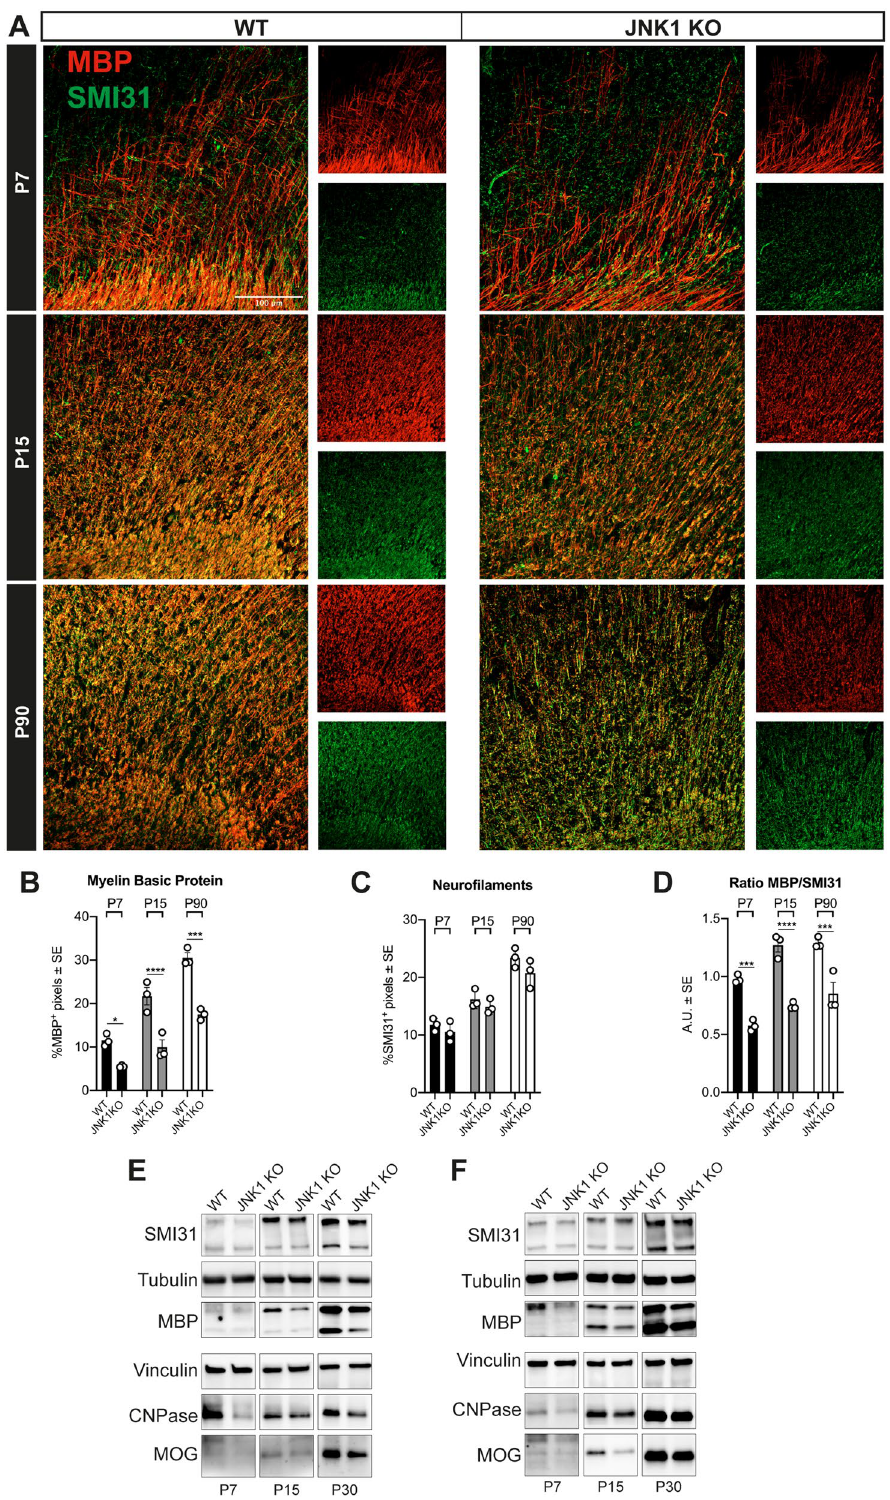
Figure 2. Myelin alterations in JNK1 KO are not related to axonal abundance. ( A ) MBP + (red) and SMI31 neurofilaments (green) expression in the cortex and CC of P7, P15 and P90 WT vs JNK1KO mice. At P7 images illustrate the deep layers of the motor cortex, nearby cingulum bundle. Quantification of the percentage of MBP + ( B ), and SMI31 ( C ) pixels in the cortex and in CC of WT vs JNK1KO mice, and their ratio ( D) . ( E ) Western blots of P7, P15 and P30 WT and JNK1KO cortices and ( F ) corpora callosa. Full length blots are presented in Suppl. Fig. 5 ( A —cortices, B— corpora callosa). Scale bars: 100 μm. WT wild type, P postnatal day, A.U. arbitrary units, MBP Myelin Basic Protein, SMI31 neurofilaments, CNPase 2 ′ ,3 ′ -Cyclic-Nucleotide 3 ′ -phosphodiesterase, MOG Myelin Oligodendrocyte Glycoprotein. *P < 0.05; **P < 0.01; ***P < 0.001; ****P <